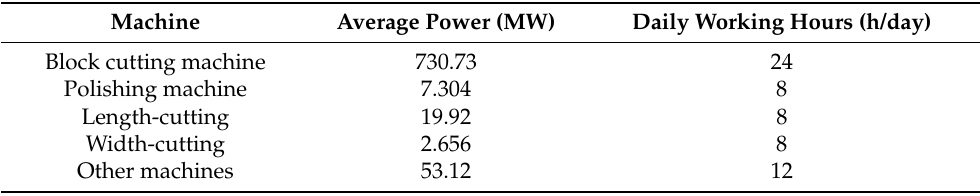
Table 6. Stonecutting load curves in Shams Abad (full-load assumption).